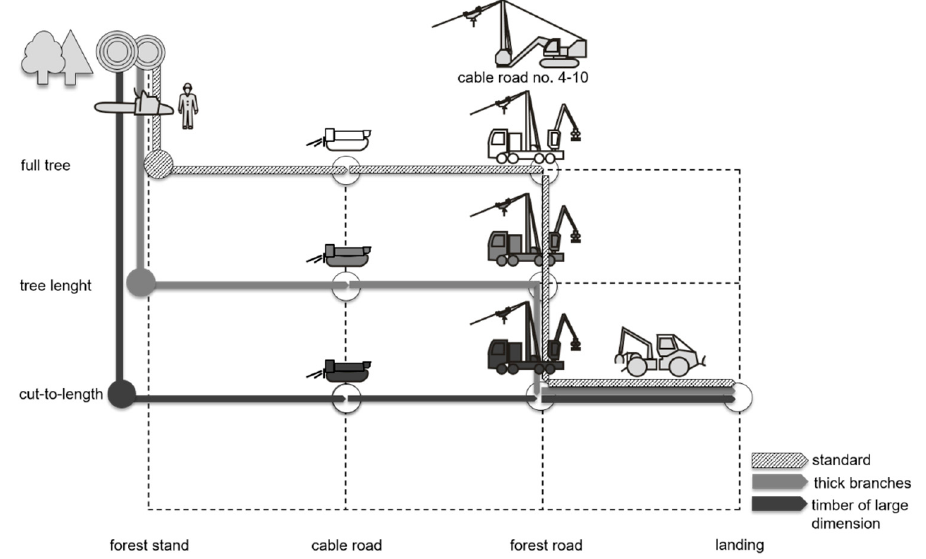
Figure 1. Operational setup of the cable-based system: working steps include motor-manual felling, extraction of (mainly) full trees, and processing by processor. An excavator with tail spar function was used in cable roads nos. 4–10. Table 1. Number and length of cable roads, amount of intermediate supports (IS), use of excavator with tail spar function, and amount of harvested biomass in the applied cable-based system.